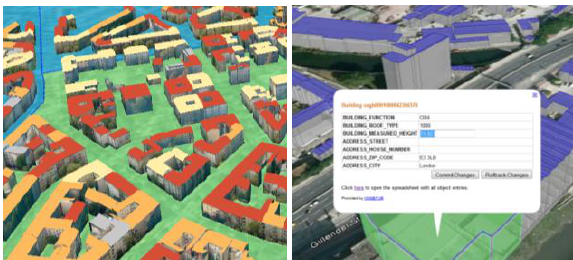
Figure 1. Virtual 3D city models as database for the Energy Atlas Berlin (left) and London (right)